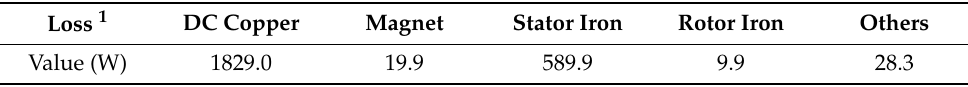
Table 7. Power loss distribution at base speed (12,000